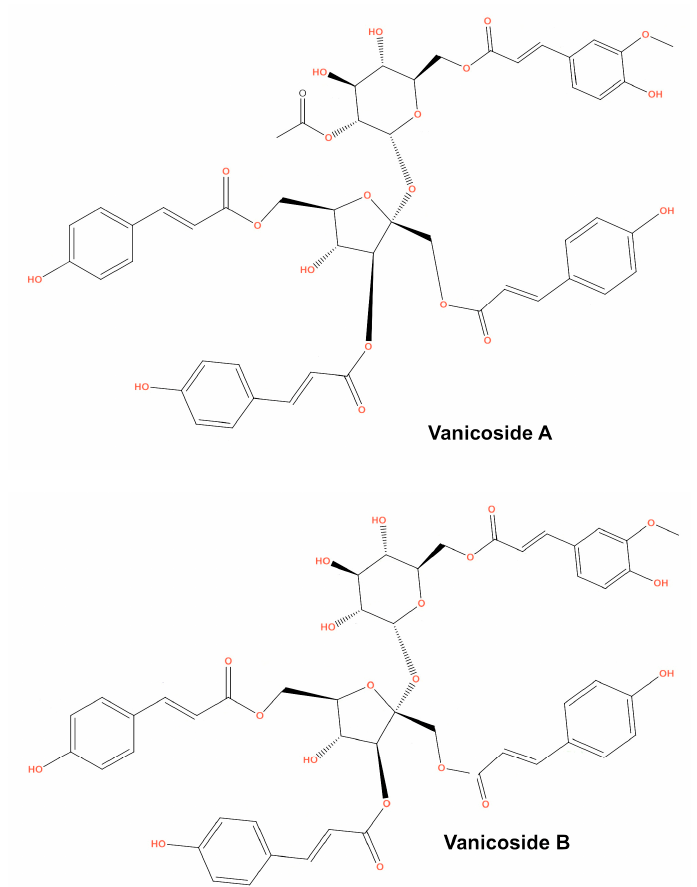
Figure 1. Chemical structure of vanicosides A and B .